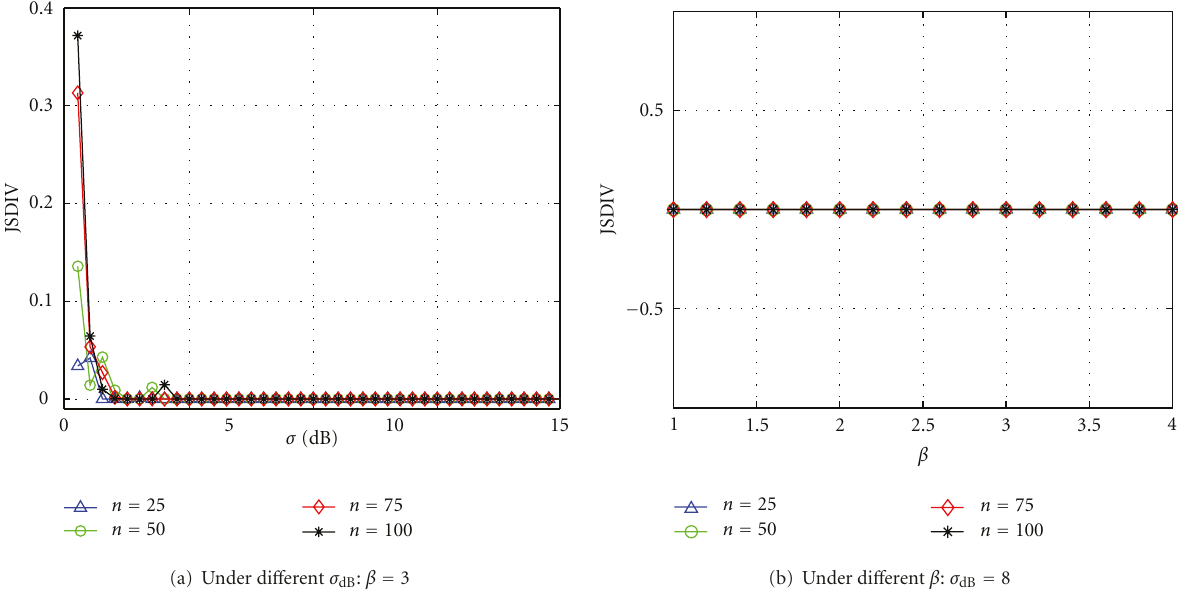
× f ! and f " ( " M n , ! I n ) M n I n